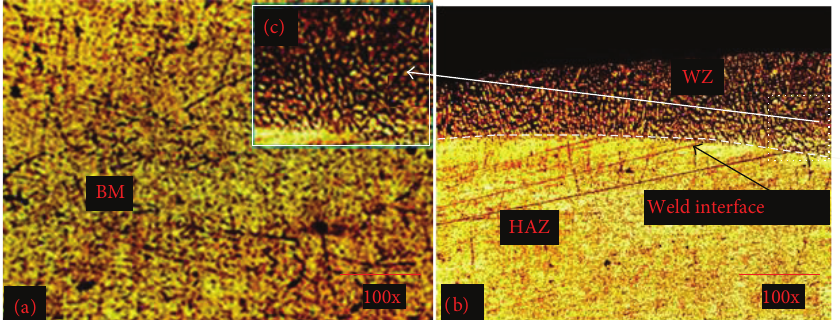
Figure 11: The welding morphology of the Al-Al GMAW joint depicts the microstructure of the (a) BM and (b) WZ and HAZ. The transition of grain structure from columnar dendritic to equiaxed dendritic is illustrated in the enlarged region of WZ in